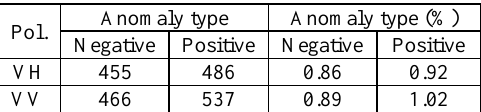
Table 3: Absolute and relative number of anomalous